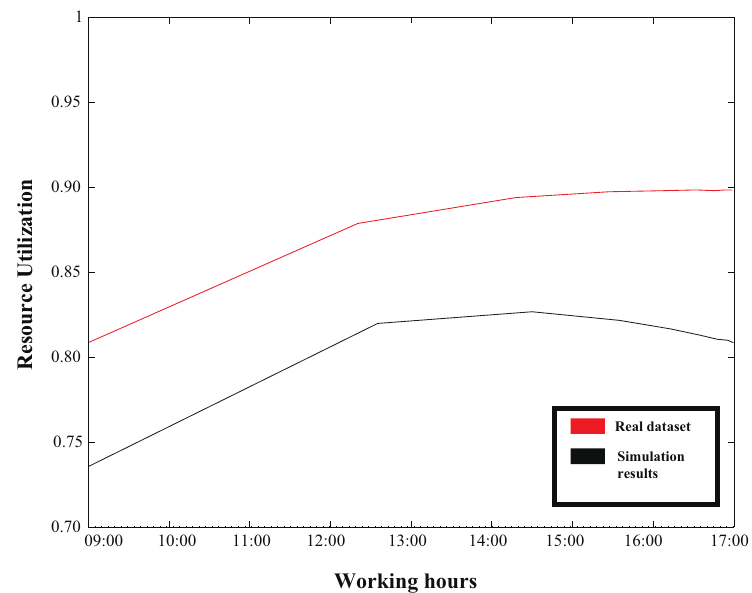
Figure 12. Comparing the actual and simulated human resource (drivers) utilization values.